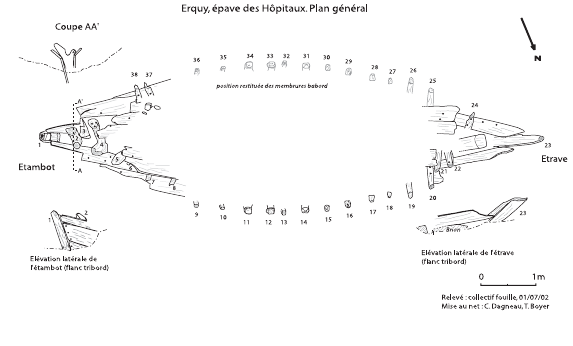
Figure 4. Sketch of the